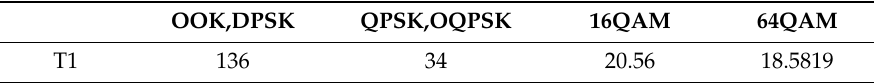
Table 2. Theoretical values of T1 for six wireless signal modulations.